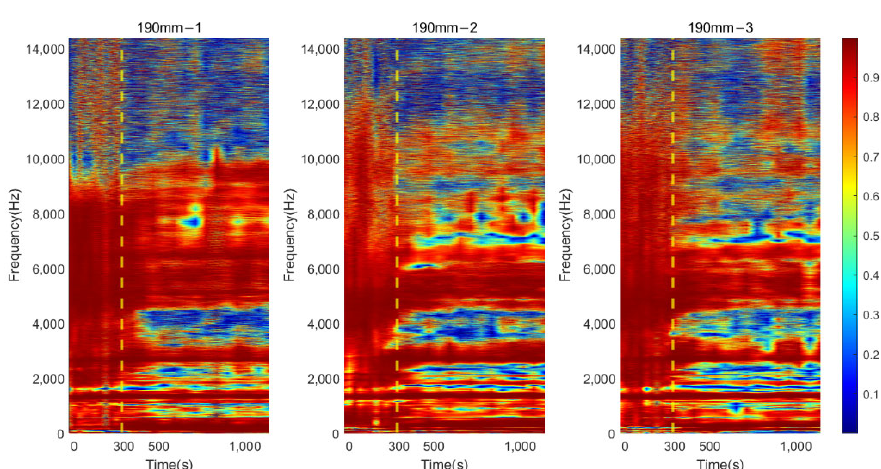
Figure 5. Coherence function for residual length of 190 mm.